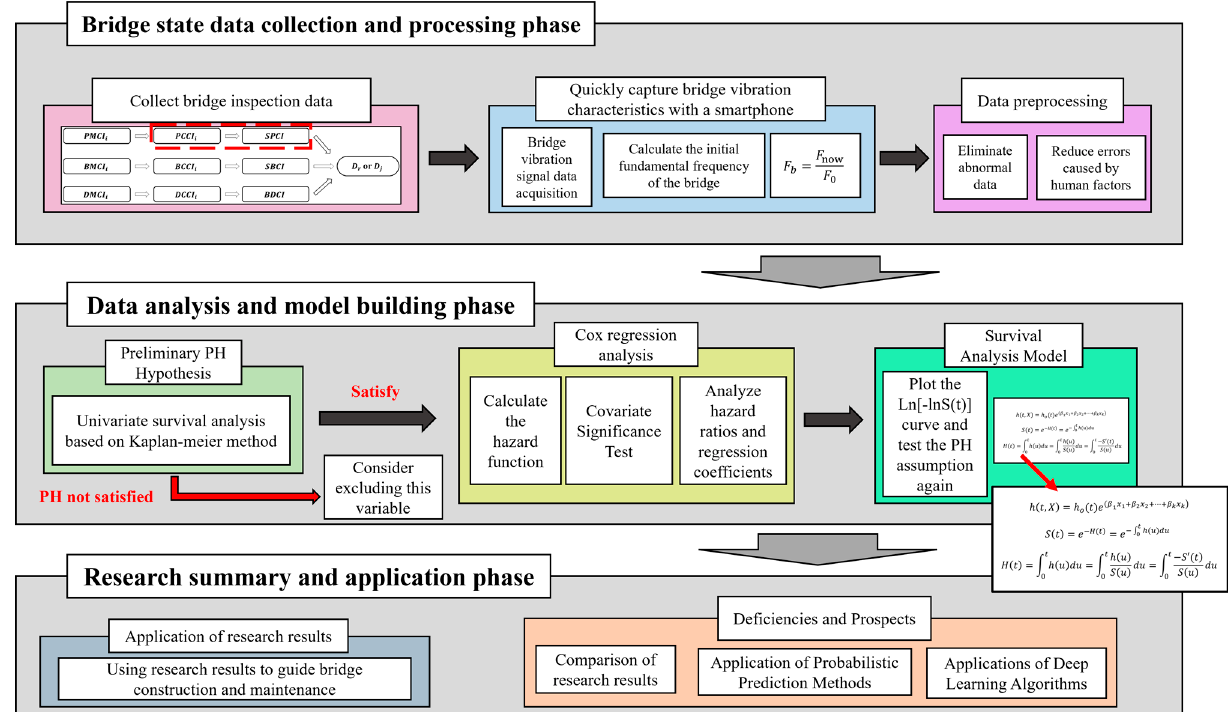
Figure 1. Overview of research